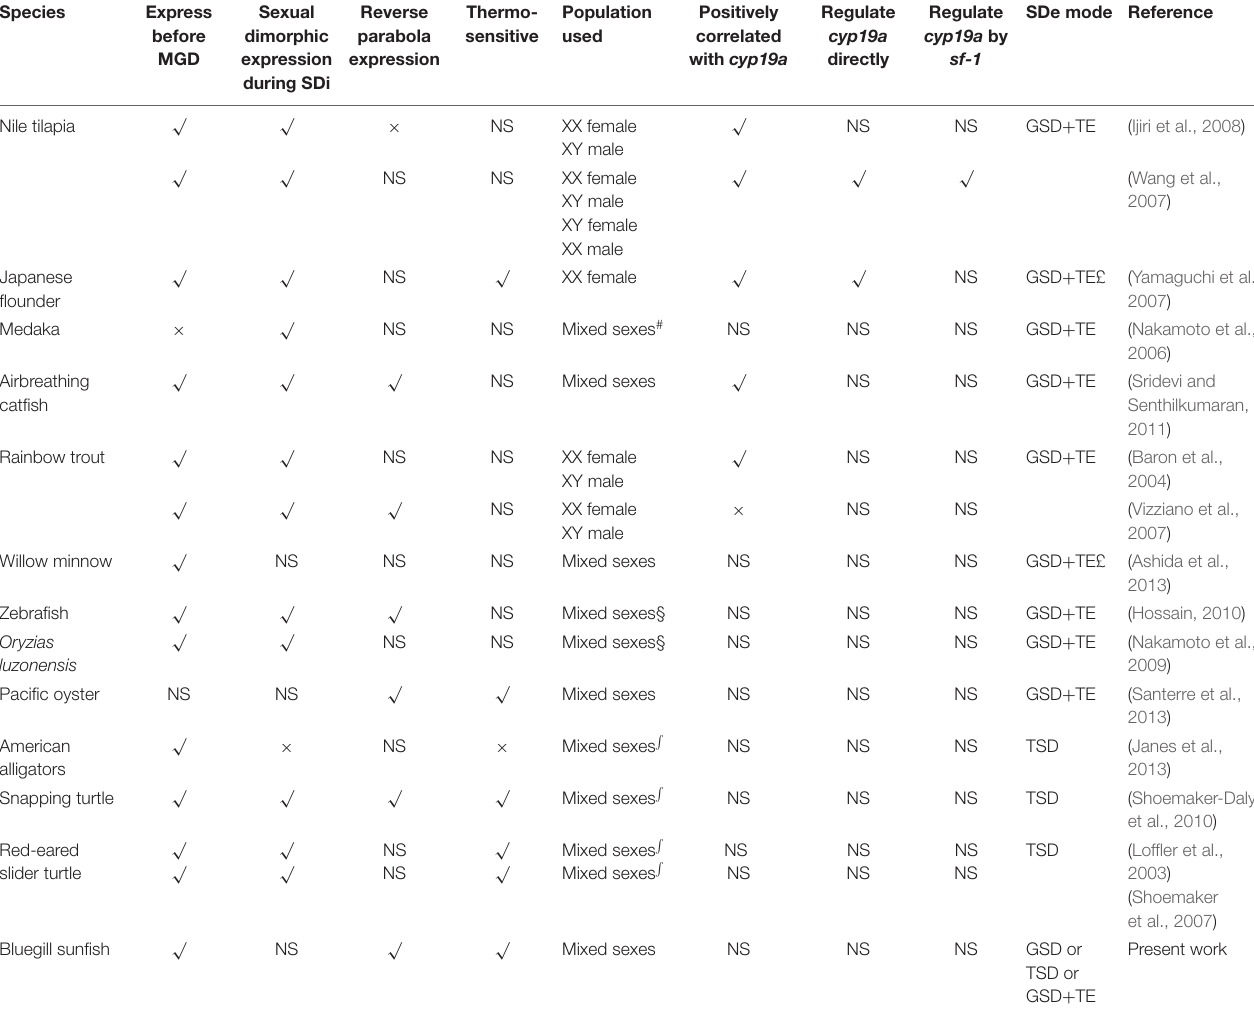
TABLE 1 | foxl2 expression profile.